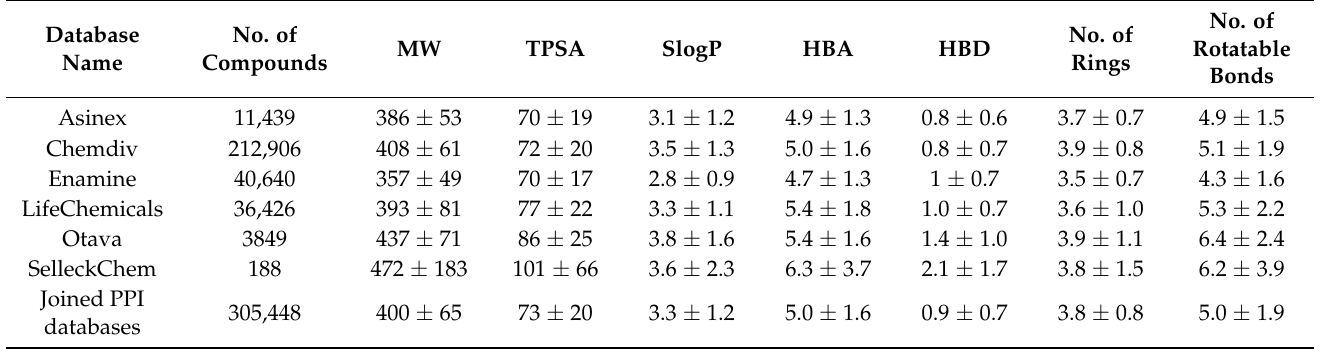
Table 6. Analysis of the most important descriptors for the protein–protein-interaction-inhibitor- targeted